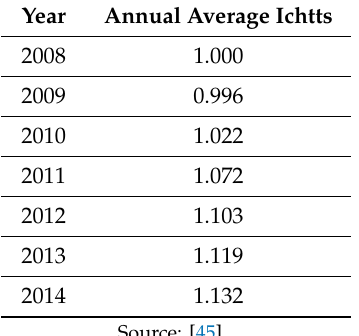
Table 3. Historical values in France of Revised Work Hourly Cost Index (Base 2008).